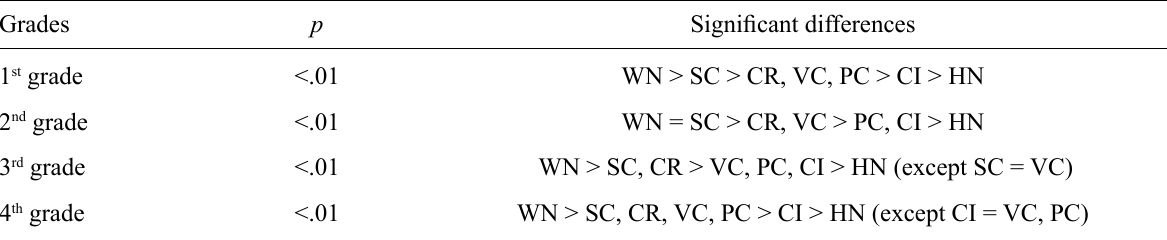
Post-hoc Comparisons (LSD) Obtained After Repeated Measures ANOVA of the Effect of Subtest on the Performances on WNw-RCT Subtests for Each Grade Level Grades p Signi fi cant differences